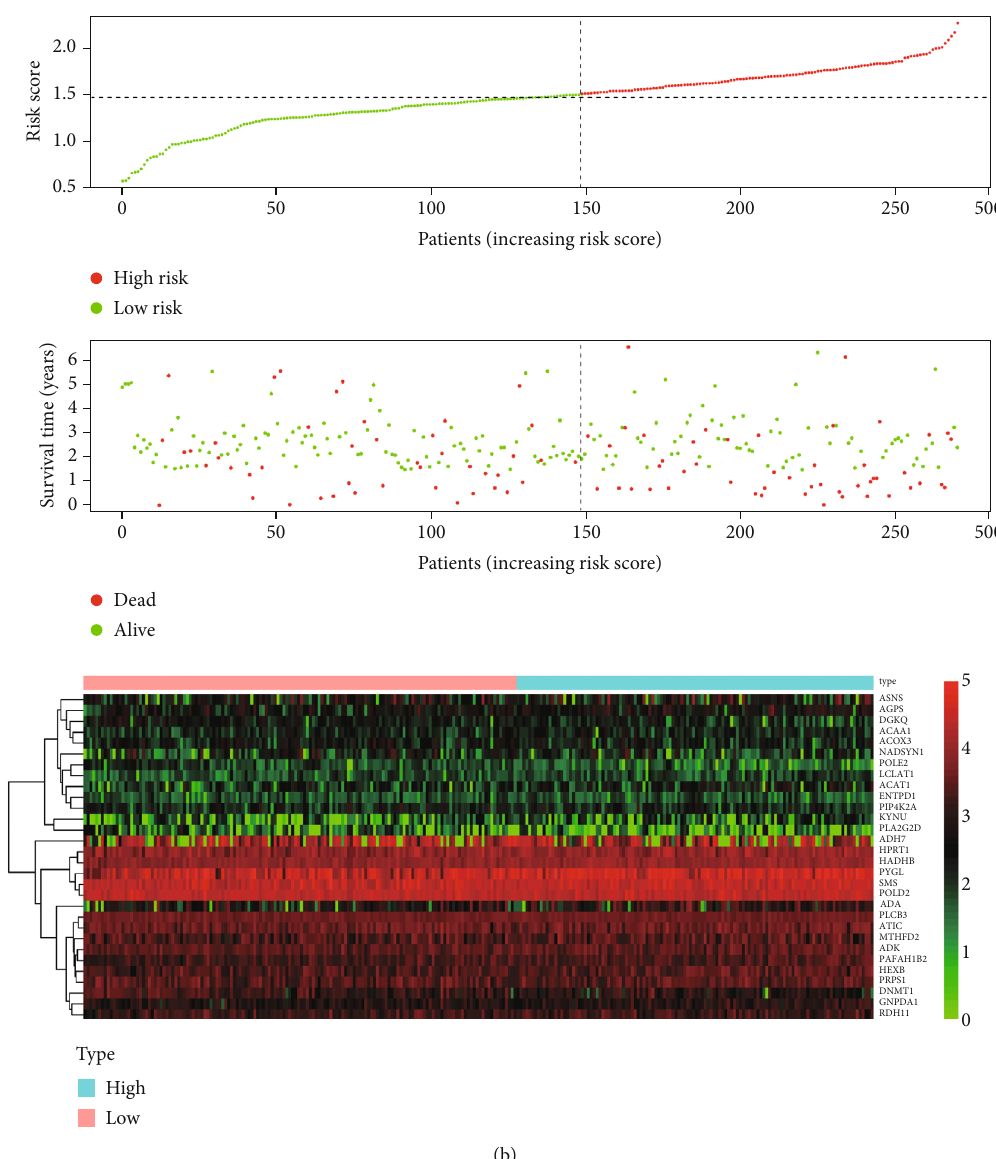
Figure 2: Detailed prognostic signature information of HNSCC groups is